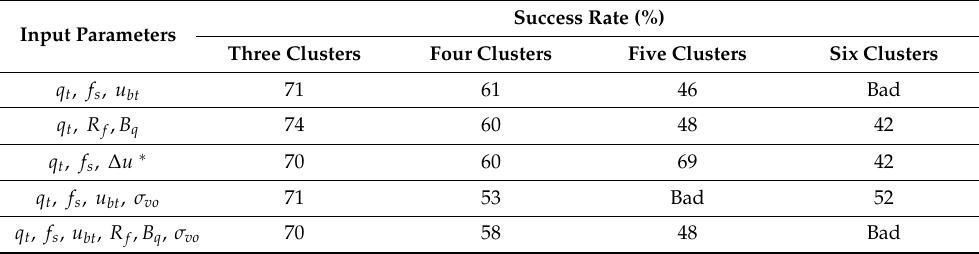
Table 3. Success rate of FCM clustering for selected input parameters and specified